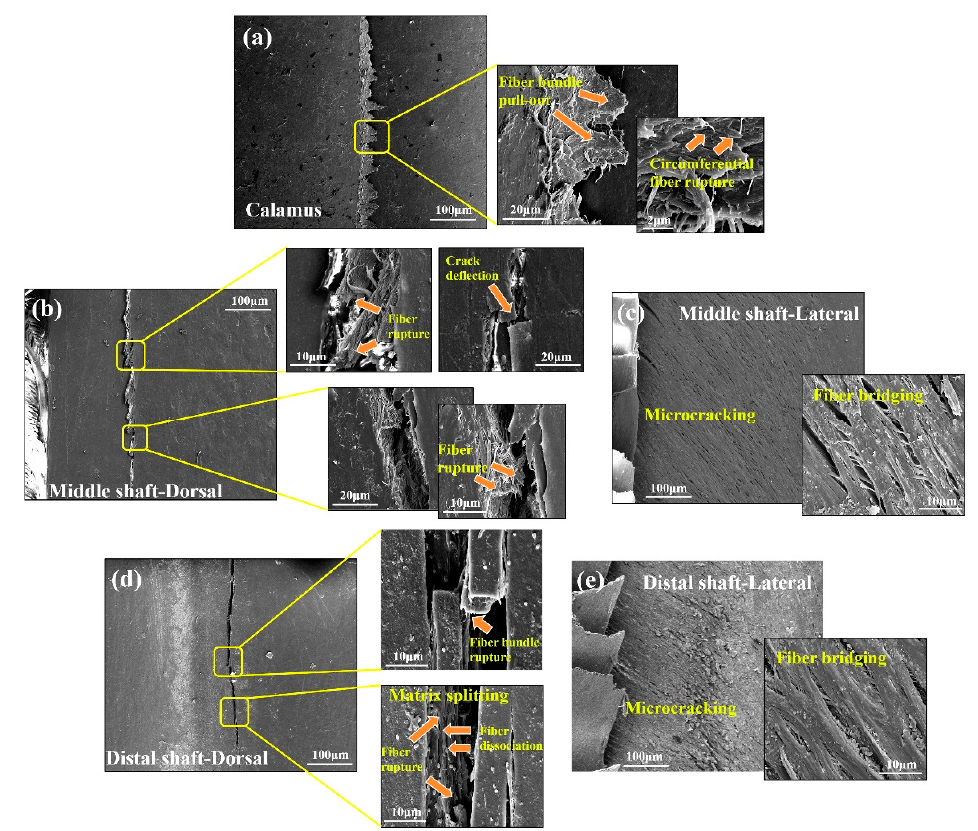
Figure 8. Fracture morphologies of ( a ) calamus, ( b ) dorsal cortex, and ( c ) lateral cortex of middle shaft, and ( d ) dorsal cortex and ( e ) lateral cortex of distal shaft.